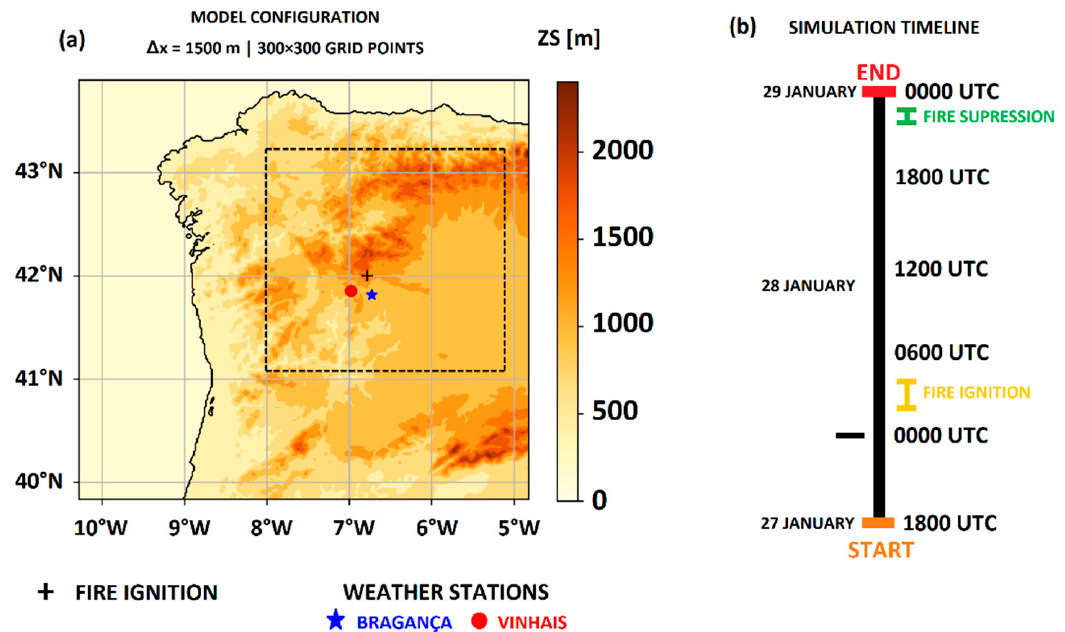
Figure 1. Numerical experiment: ( a ) model configuration with a domain at 1500 m horizontal resolution and orography (unit: metres; coloured areas) obtained from the SRTM database. The symbols indicate the fire location considered in the case study (see Section 2.2) and the weather stations. ( b ) Numerical experiment timeline. The dashed-line rectangle represents a zoom area.